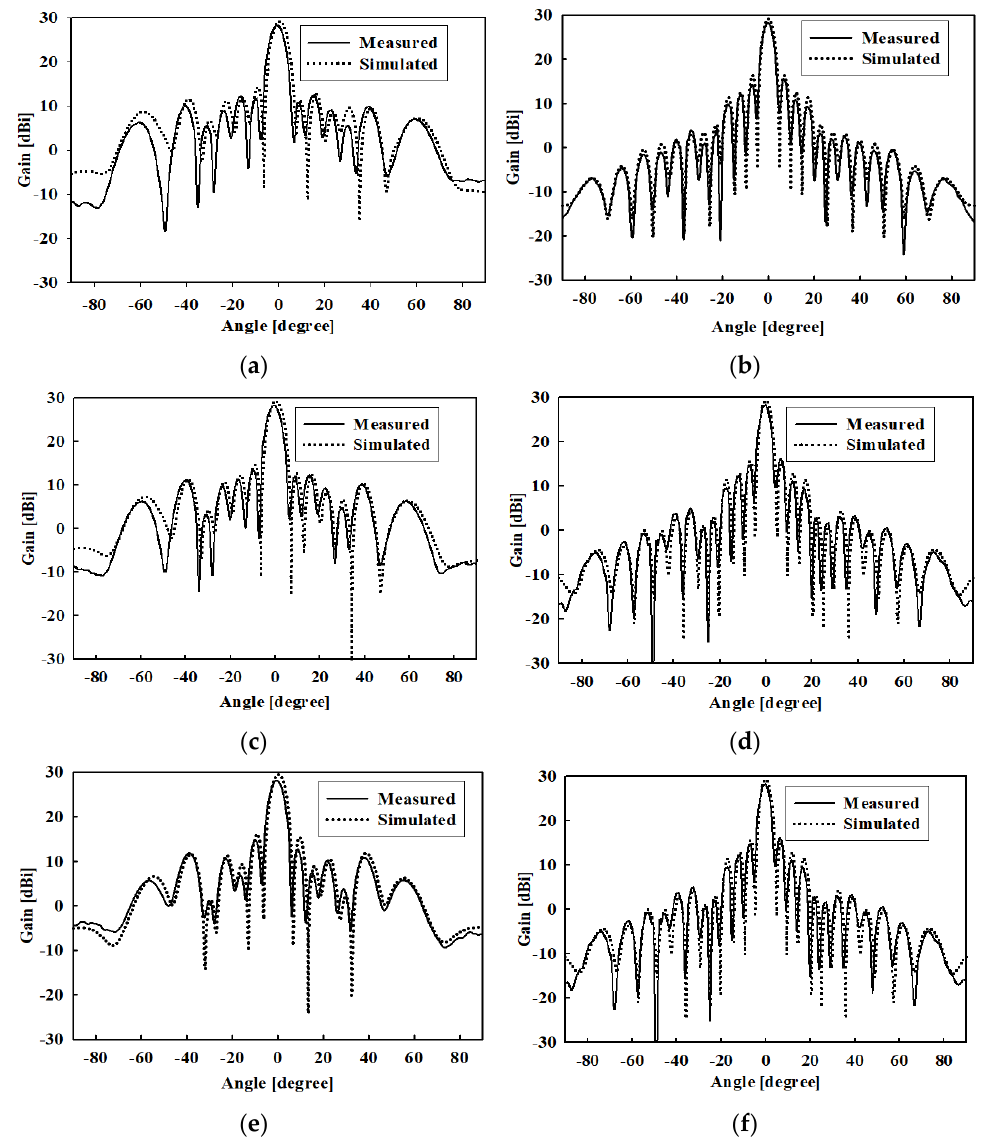
Figure 10. Measured and simulated farfield radiation patterns of the proposed array antenna. ( a ) 9.3 GHz, XOZ-plane, ( b ) 9.3 GHz, YOZ-plane, ( c ) 9.65 GHz, XOZ-plane, ( d ) 9.65 GHz, YOZ-plane ( e ) 9.9 GHz, XOZ-plane, and ( f ) 9.9 GHz, YOZ-plane.